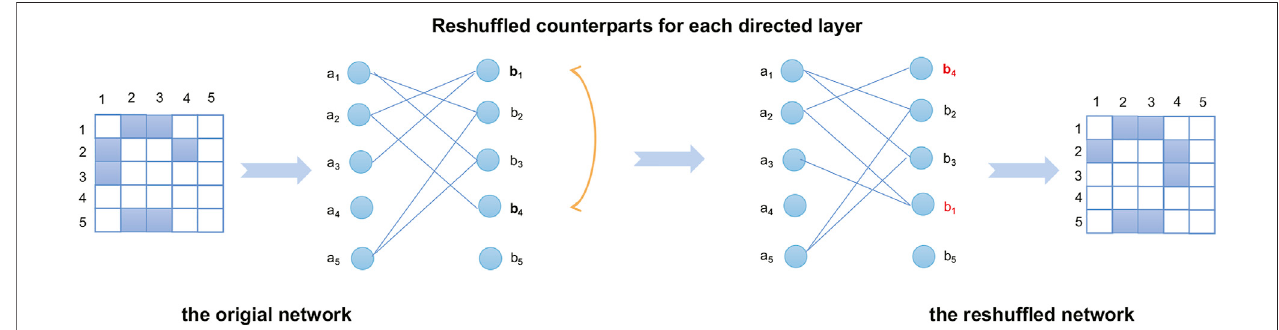
FIGURE 4 | Illustration of the reshuf fl ed counterpart of original networks. In the example, we exchanged the ids of nodes b 1 and b 4 , thereby destroying the intra- layer topological similarity.